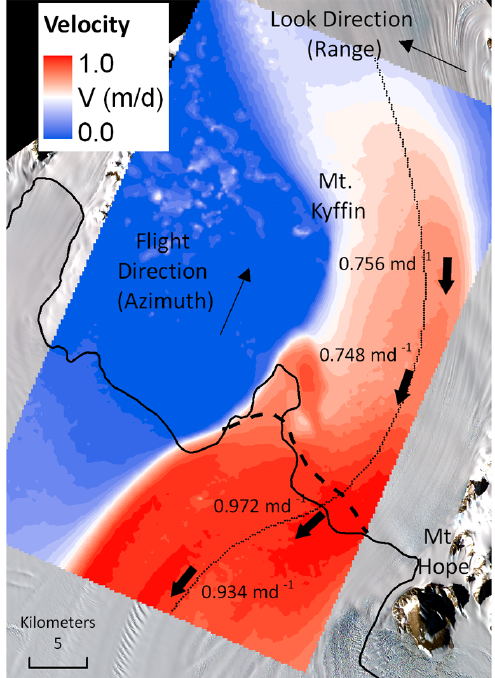
Fig. 3. Absolute velocity across the Beardmore Glacier grounding line created by stacking velocity data from 1/2 December, 1/2 June and 2/3 June. Velocity arrows show TerraSAR-X velocities at GPS points for comparison with Fig. 1.